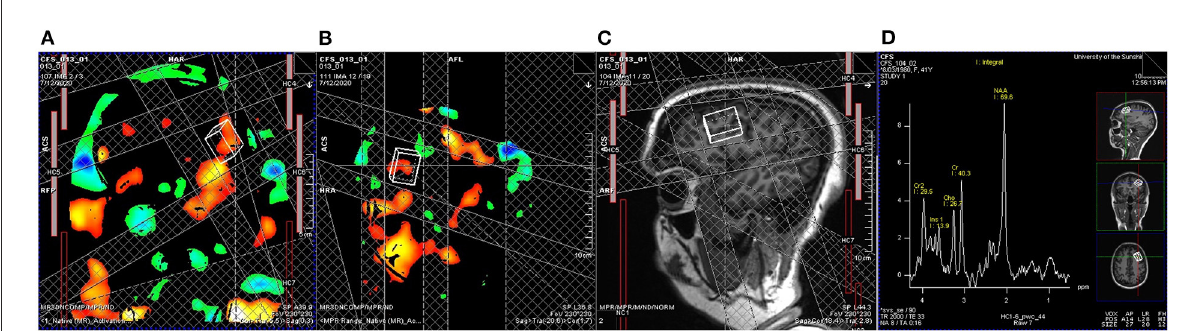
FIGURE3 Real-time task fMRI guided functional magnetic resonance spectroscopy (fMRS). A general linear model determined BOLD signal changes associated with the symbol digit modalities test implemented on the MRI scanner with a threshold of uncorrected P < 0.001. A cuboid voxel covering the left dorsal prefrontal cortex (20mm from superior to inferior, 27mm from anterior to posterior, and 12mm from left to right) is adjusted according to BOLD activation maps, (A) coronal and (B) sagittal views, and (C) T1-weighted anatomic images to cover left dorsal prefrontal cortex. (D) An example of a measurement averaged from 8 volumes from another participant shows the exact anatomical location and the acceptable signal-to-noise ratio for estimating the glutamate level.